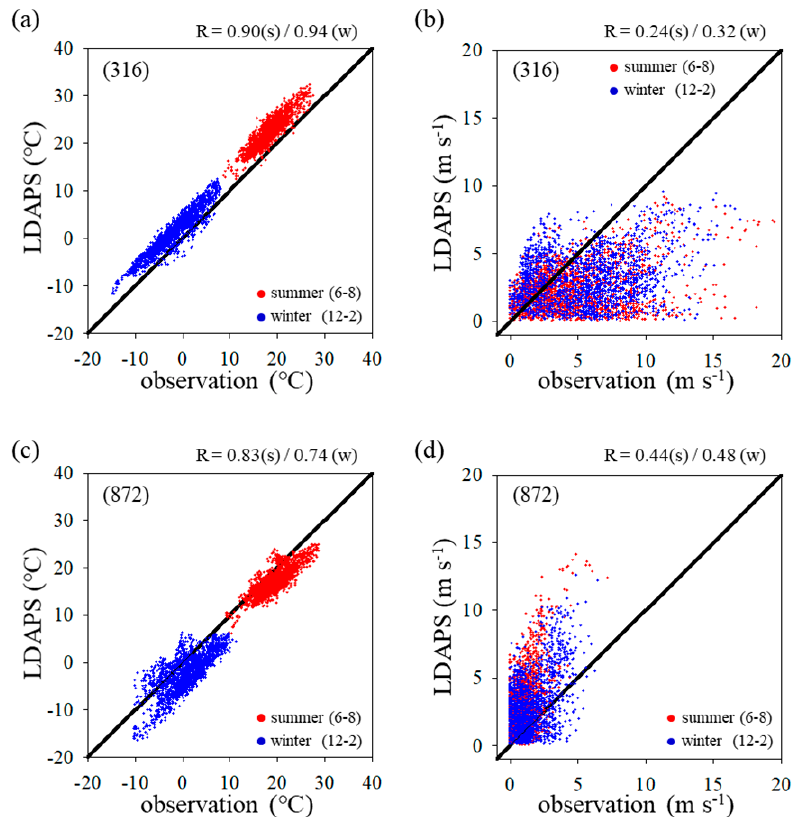
Figure 9. Scatter plots of the AWS-observed and LDAPS-predicted temperatures (left panels) and wind speeds (right panels) at the ( a , b ) AWS 316 (LDAPS altitude < AWS altitude) and ( c , d ) AWS 872 (LDAPS altitude > AWS altitude). Red and blue dots indicate for summer season (June, July, and August) and winter season (December, January, and February), respectively.